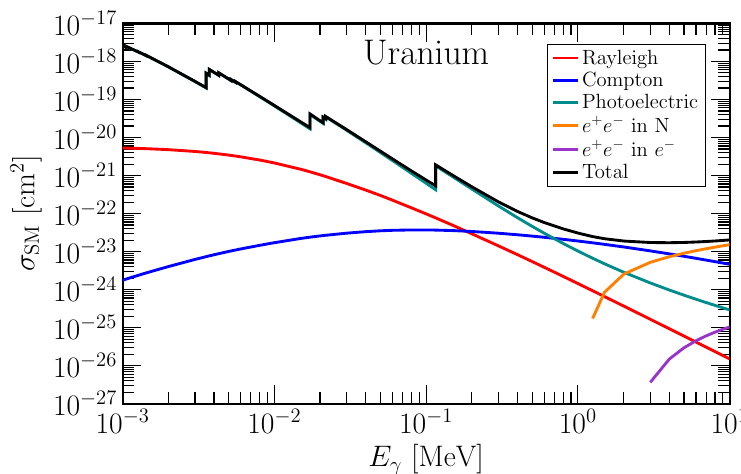
Figure 4 . SM photon cross sections for uranium taken from the XCOM photon cross section database